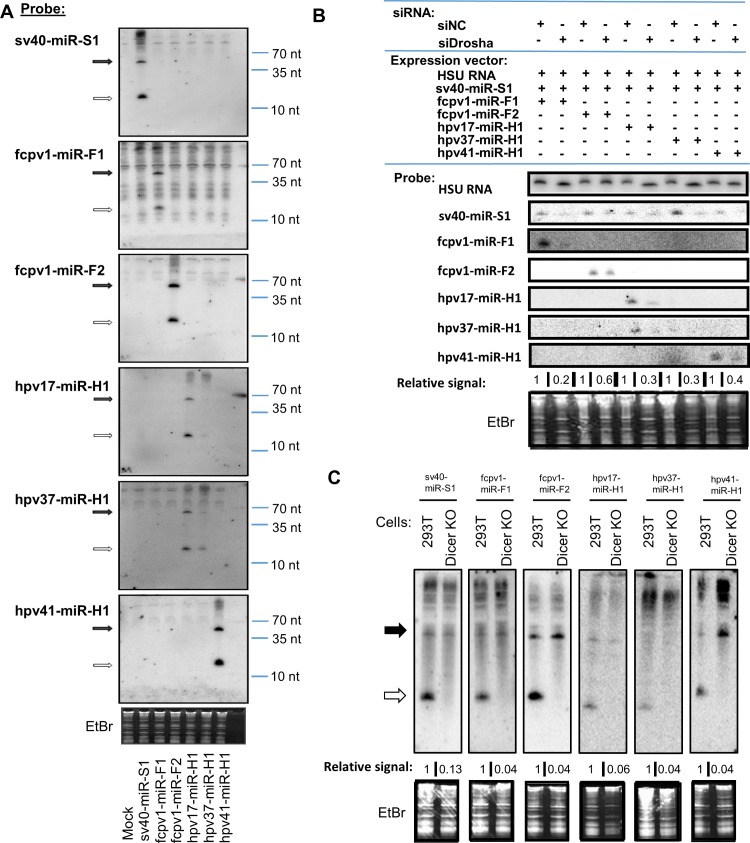
MiRNA candidates identified from miDGE analysis are detected by Northern blot.(A) Northern blot analysis of total RNA from HEK293T cells transfected with indicated miRNA or putative miRNA expression vectors, with ethidium bromide stained low molecular weight RNA shown as a load control. This figure represents a single membrane that was probed first for control SV40 miRNA, then stripped and re-probed for each of the indicated miRNAs. Solid and outline arrows on left side correspond to pre-miRNAs and mature miRNAs, respectively, and approximate sizes are noted on right side. (B) Northern blot analysis of total RNA from HEK293T cells transfected with anti-Drosha siRNA or negative control (NC) siRNA, then re-transfected after 48 hours with respective siRNAs and indicated putative miRNA expression vectors. Total RNA was harvested after 48 hours. Ethidium bromide stained low molecular weight RNA shown as a load control. This figure represents a single membrane that was probed first for control SV40 miRNA, then stripped and re-probed for each of the indicated miRNAs. Membrane was additionally probed for HSUR (Herpesvirus saimiri U RNA 4) as a transfection control. Normalized to HSUR RNA, all indicated miRNAs are detected at higher intensity in negative-control-treated cells than Drosha knockdown cells, suggesting canonical dependence on Drosha processing. The numbers below each blot correspond to the ratio of mature miRNA signal in control cells compared to mature miRNA signal in Drosha-knockdown cells after each signal has been normalized to load control HSUR signal. Note: due to sequence similarity between putative HPV-derived miRNAs, cross-reactivity is seen in hpv17-miR-H1 lanes and hpv37-miR-H1 lanes. (C) Northern blot analysis of RNA from either HEK293T or Dicer KO (NoDice [68]) cells transfected with the indicated miRNA expression vectors. Solid and outline arrows on left side correspond to pre-miRNAs and mature miRNAs, respectively. The numbers below each blot correspond to the ratio of mature miRNA signal to pre-miRNA signal, normalized to the same ratio in HEK293T cells. This figure represents a single membrane that was probed, then stripped and reprobed with the indicated oligonucleotide probes (SV40, FcPV1 F1 and F2, HPV41 miRNA probes) and a second membrane for HPV17 and HPV37 miRNAs. Ethidium bromide stained low molecular weight RNA is shown as a load control.